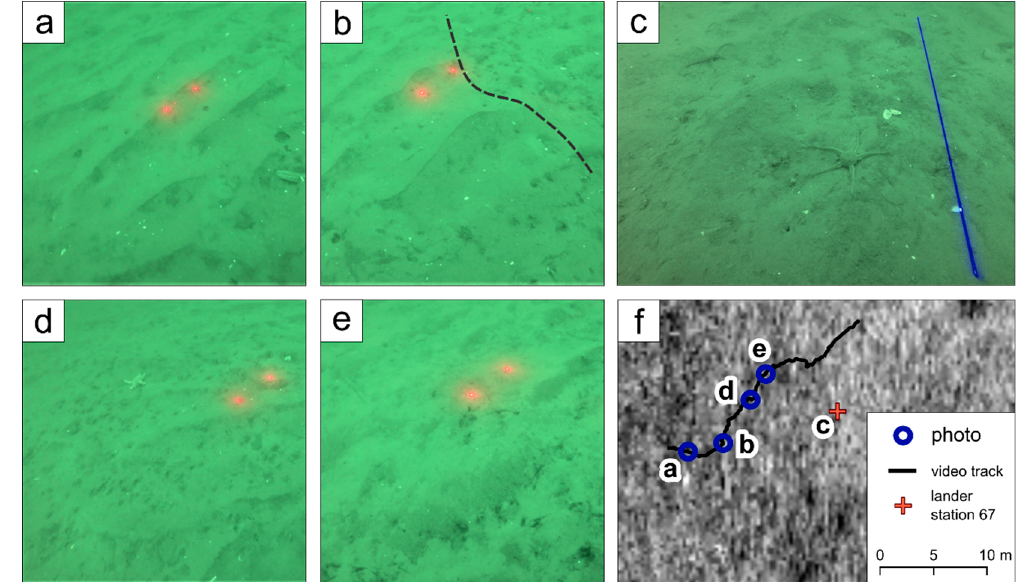
Figure 5. Video footage from a survey near station 63_1 ( a ), ( b ), ( d ), ( e ) (red dots have a 10 cm distance), from the lander station 67 ( c ) and the corresponding position in the ship-based backscatter mosaic ( f ). ( a ) reveals asymmetrical straight to sinusoidal ripples with sparse benthic coverage and organic fluff located inside the ripple troughs. ( b ) indicates the transition is between the ripple-dominated and the benthic-dominated seafloor type. In ( c ), degenerate ripple structures were observed with few tubeworm structures, shell fragments, and brittlestars (Ophiuroidea). ( d ) reveals degraded ripple residuals and a higher coverage of tubeworm structures, few starfish, and larger shell fragments. The morphology in ( e ) shows no ripple structures and very few visible epibenthic features besides some organic fluff. The ship-based backscatter mosaic in ( f ) shows a corresponding change from low to high backscatter along the video track. However, the positioning is not sufficiently accurate to relate video snapshots directly to the backscatter mosaic.